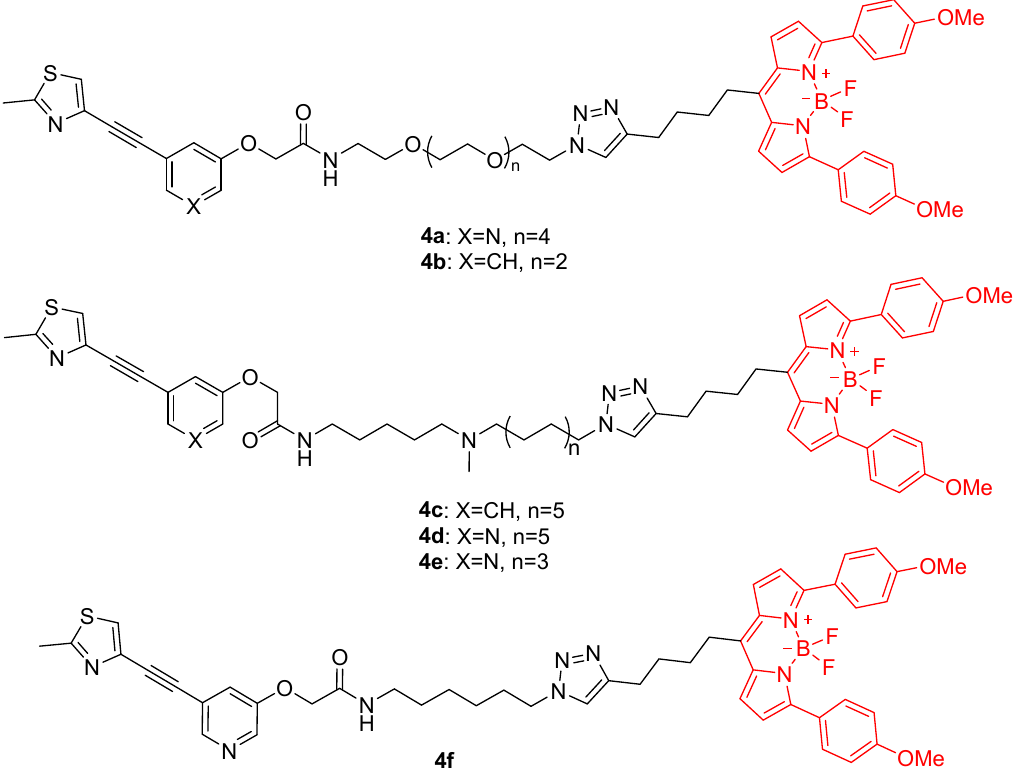
Figure 2. Structural design of the mGlu 5 R fluorescent ligands. Chemical representation of the six fluorescent NAMs ( 4a – f ) in which a boron dipyrromethene (BODIPY; shown in red) fluorophore is fused with MTEP analogues by different spacers (shown in black).